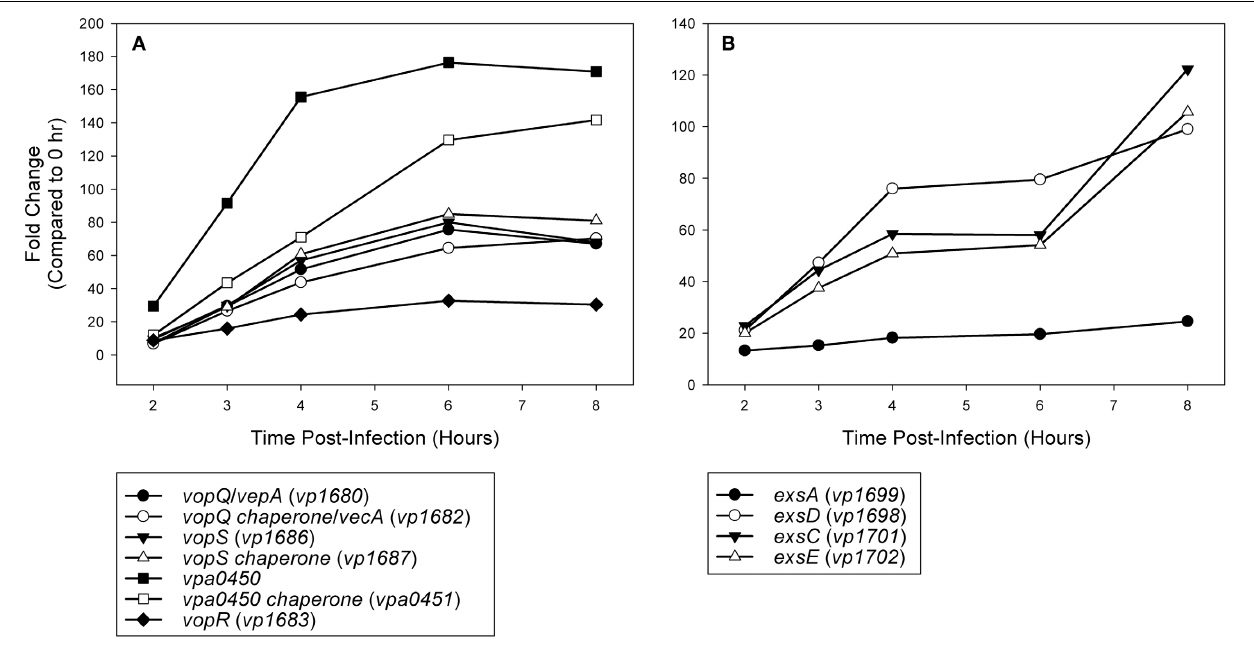
FIGURE 5 | (A) Time points during infection of HeLa cells ( n = 2 replicates) were compared to 0h (pre-infection) and fold change of known and putative T3SS1 effector protein and effector chaperone genes were plotted over time.